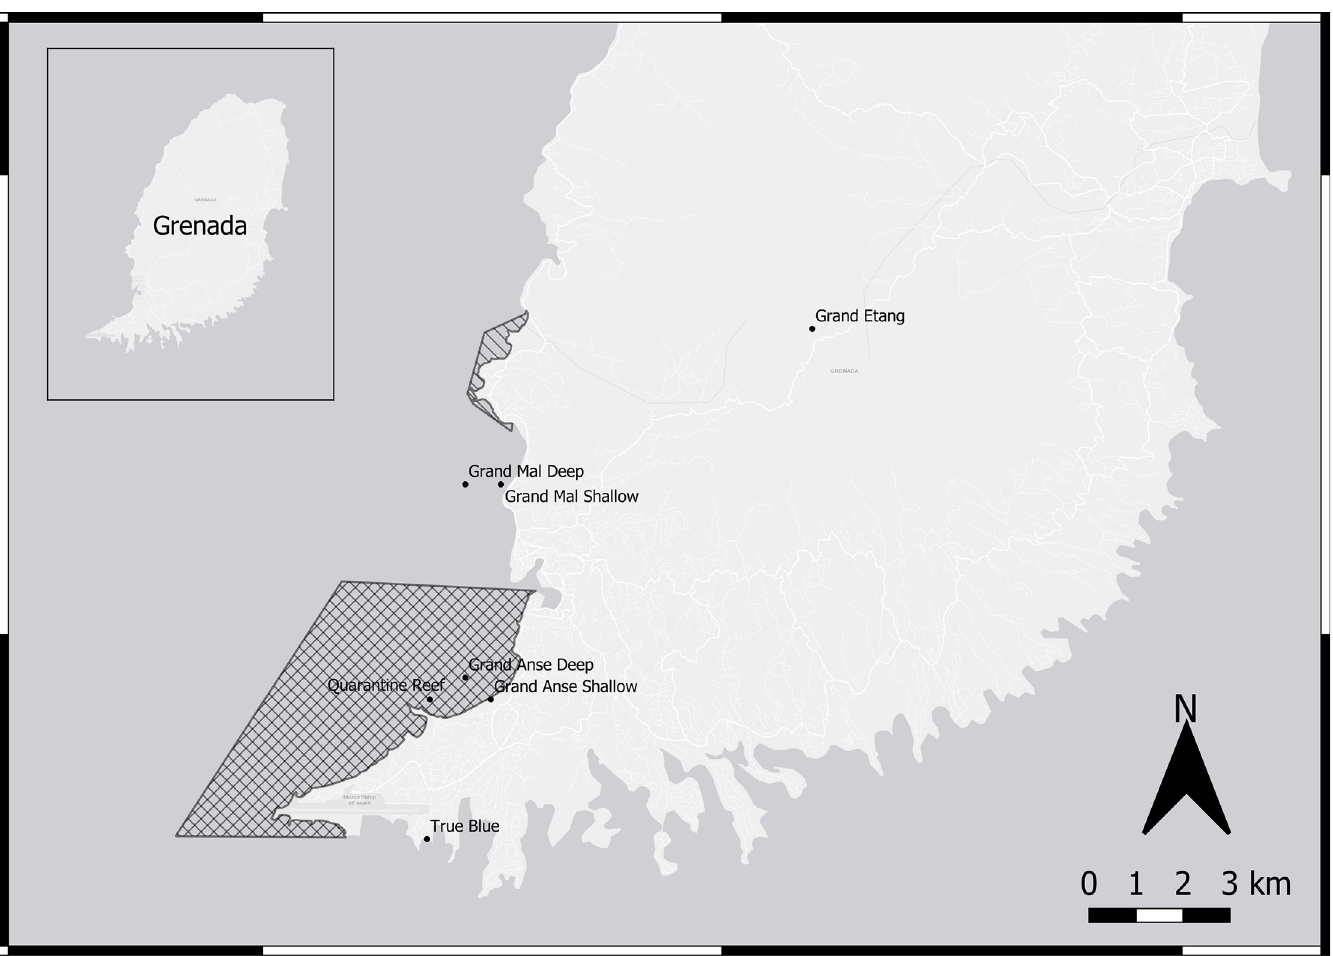
Fig 1. Locations for sampling sites in Grenada, West Indies. Boundaries of the Molinere-Beasejour marine protected area (hashed) and proposed Grand Anse protected area (crossed) are